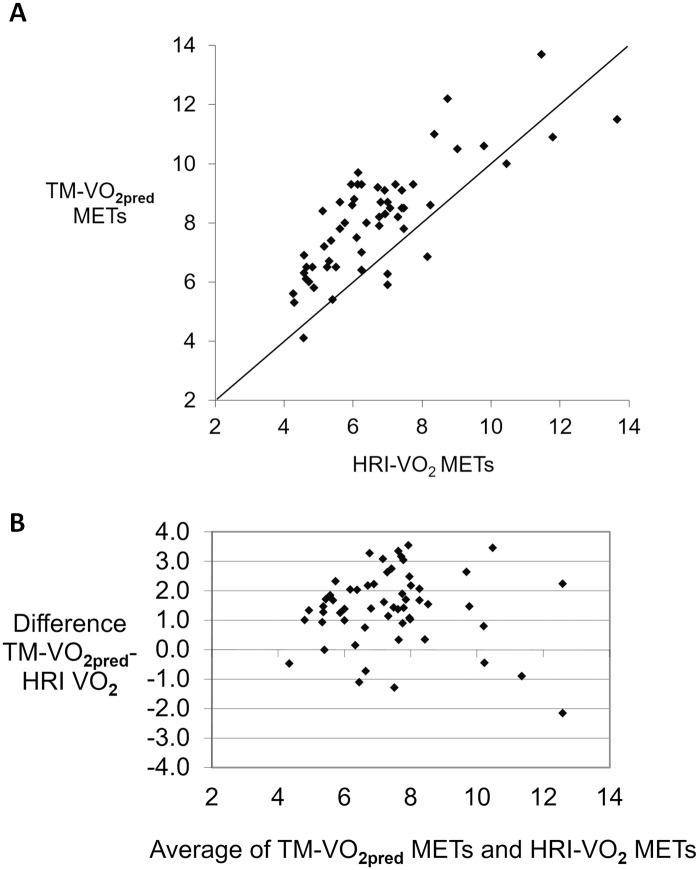
Line of identity and Bland Altman plot for TM-VO2pred.A. Line of identity for TM-VO2pred and B. against Bland Altman plot for TM-VO2pred against HRI-VO2.